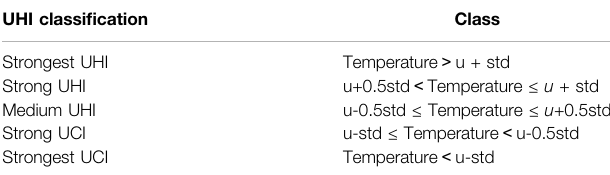
TABLE 1 | The classi fi cation of UHI and non-UHI